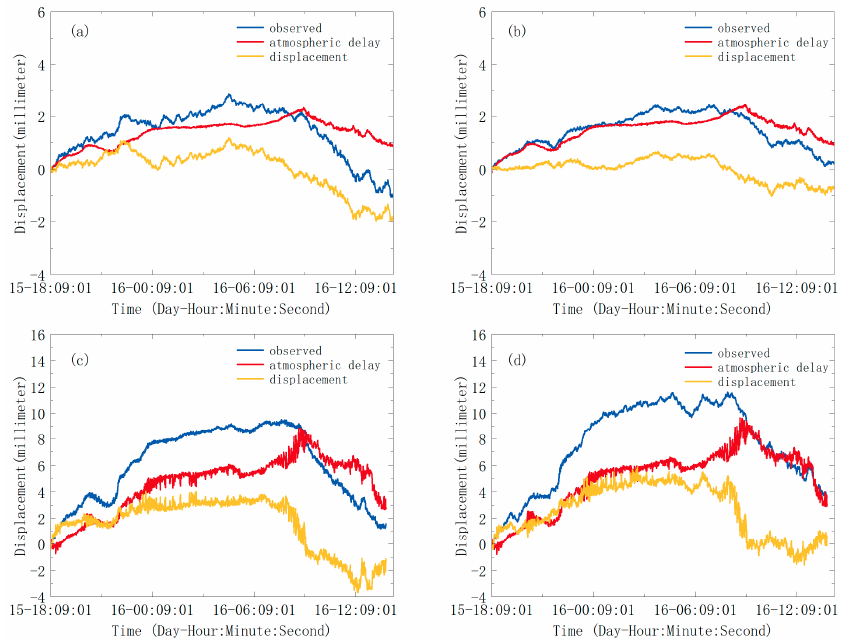
Figure 11. The time series obtained by the meteorological data of four reflectors ( a ) P 1 , ( b ) P 2 , ( c ) P 3 , and ( d ) P 4 .